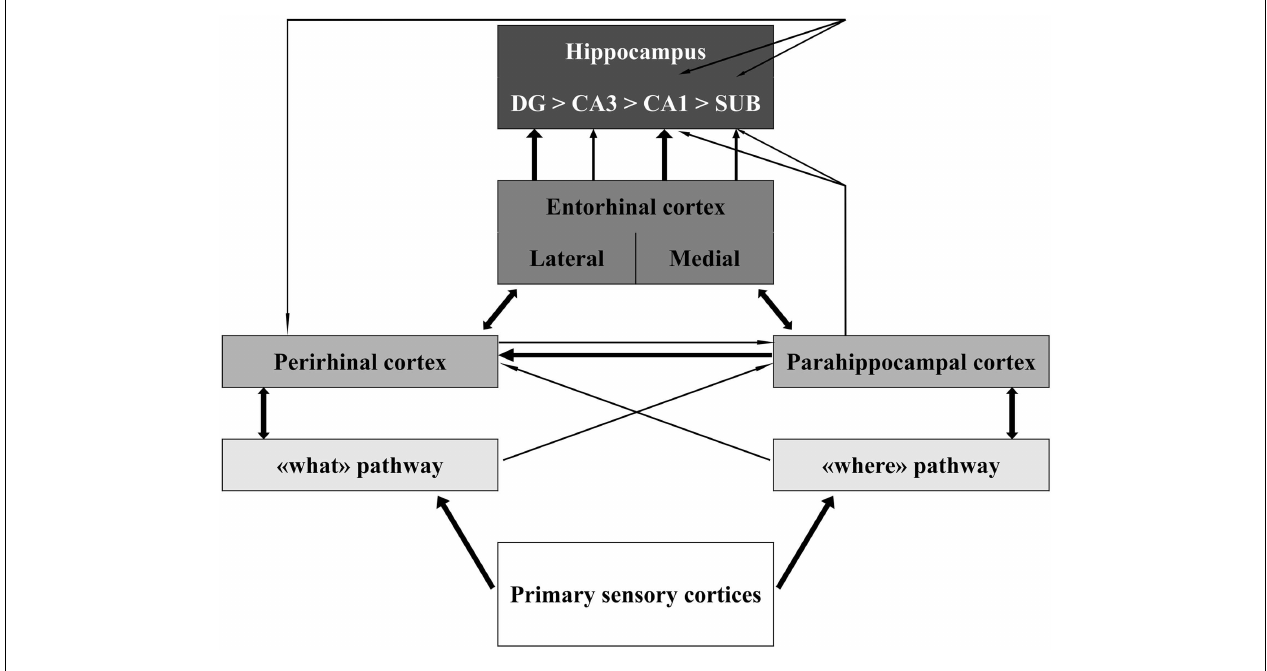
entorhinal cortices. Information about different aspects of the sensory stimulus converges in the hippocampus through largely segregated pathways. Modified from Aggleton (2012). Abbreviations: DG, dentate gyrus; CA, cornus ammonis; SUB,